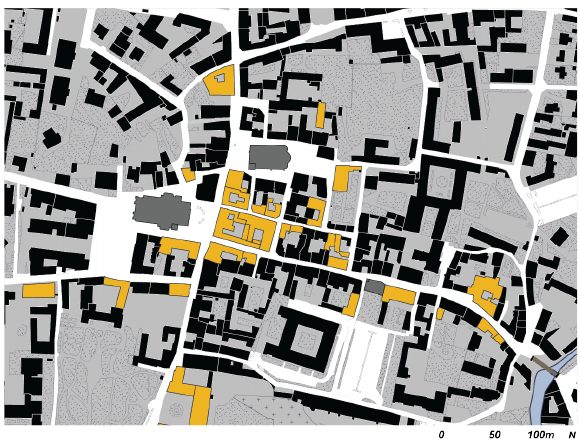
Figure 12. “Constructive approach”: A map of the presence of basements (in yellow) in the historical centre today, can indicate the previous functions and construction period. Source: authors’